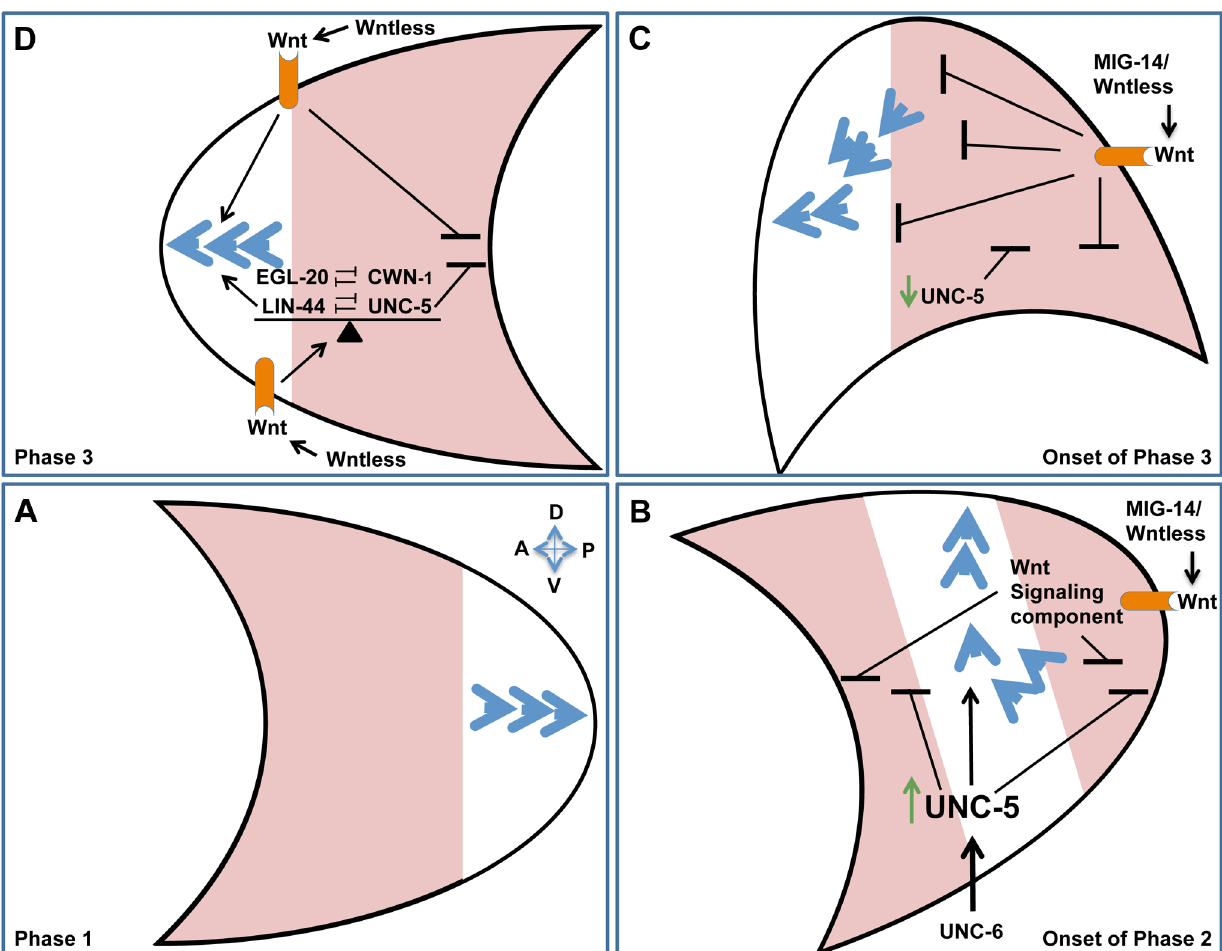
Figure 8. Orchestrating A/P and D/V guidance: A model. Polarity establishment of the posterior DTC (crescent shape) is used as an example to illustrate the redundant functions of Netrins and Wnts in A/P and D/V guidance. Anterior is to the left and dorsal is up. Blue arrowheads represent cytoskeletal polarity establishment regulators. The arrowheads points toward the leading edge of migration. During phase 1 of DTC migration, polarity is established along the A/P axis, away from the mid-body of the animal. (A) The posterior DTC migrates posteriorly (as a result of polarity establishment at the posterior pole) while the anterior DTC (not shown) migrates anteriorly. Areas shaded in pink represent regions from which polarity establishment is inhibited or excluded. (B) At the onset of phase 2, unc-5 is transcriptionally activated (green arrow) and functions redundantly with Wnt signaling components (Wnt receptor shown in orange) to inhibit polarity formation at the anterior and posterior poles, thereby restricting functional rate limiting cytoskeletal polarity regulators (blue arrowheads) to the center of the cell, confining them to the D/V axis by virtue of excluding them from the A/P poles. In addition to inhibiting A/P polarities, UNC-5 establishes directionality along the D/V axis by inducing repulsion away from ventral sources of UNC-6. The concomitant inhibition of A/P polarity and induction of D/V polarity may be essential for a sharp 90 u turn taken by the migrating DTC as it transitions from the A/P to the D/V axis. (C) At the onset of phase 3, UNC-5 appears to be down-regulated [36] and the DTC is located further away from the ventral Netrin source, hence D/V polarity may no longer be maintained and the balance between UNC-5 and Wnt signaling determines polarity establishment asymmetrically on the anterior pole of the posterior DTC, thereby facilitating migration back towards the mid-body. (D) Phase 3 polarity maintenance is dependent on the balance (indicated by a triangular fulcrum) between Wnt and UNC-5 signaling. This balance determines on which of the poles, if any, polarity can be established. There are therefore three possible scenarios: 1) limiting polarity to the posterior or 2) limiting it to the anterior pole, which would result in posterior or anterior migration, respectively, or 3) Limiting polarity to the center of the cell, which would result in a halt, or a migratory transition to the D/V axis. Any of the scenarios (or some combination) could be regulated by the balance between Wnt and UNC-5 signaling.